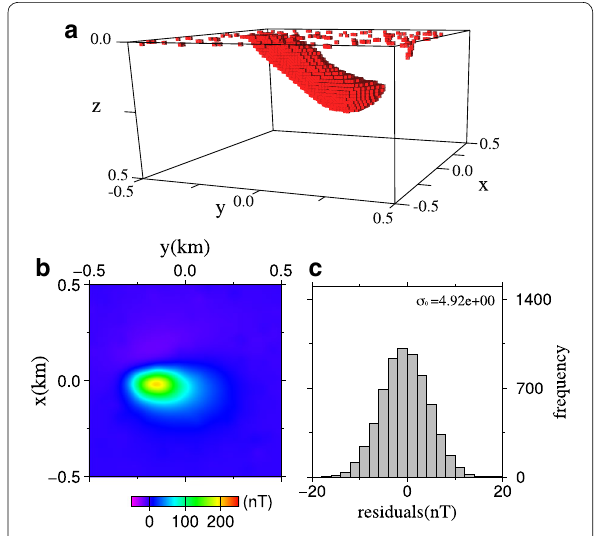
Fig. 17 An optimal model derived by L1–L2 norm regularized inversion. An optimal model derived by L1–L2 norm regularized α S 1 0.96 using weighting function w S 1 . a A inversion with ˆ =